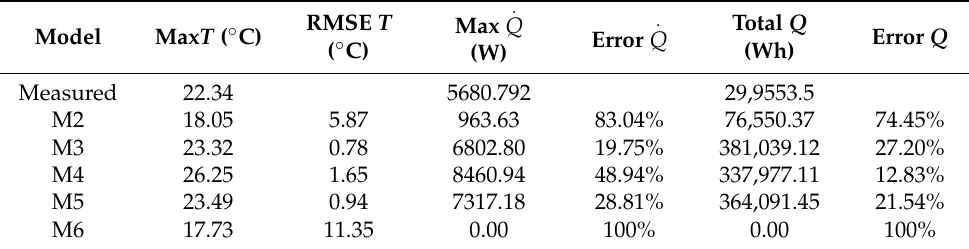
Table 5. Model output in a closed loop to track indoor temperature for the real